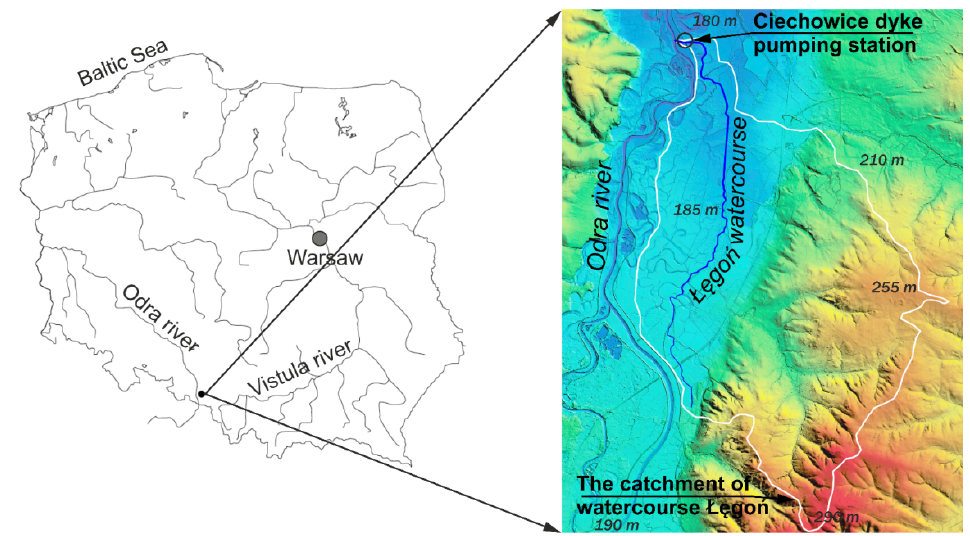
Figure 1. Location of the study area (Łęgoń watershed) and the digital elevation model.